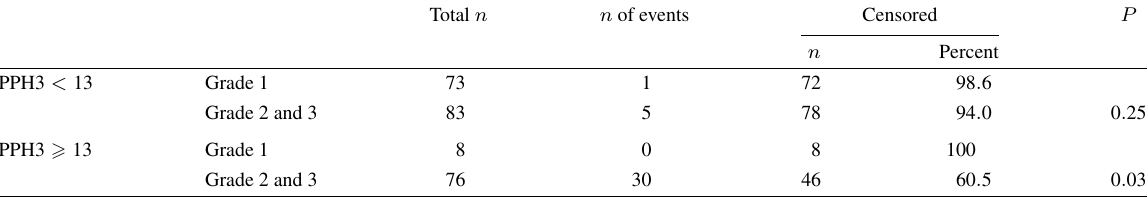
Grade 1 versus Grade 2 and 3 stratified for PPH3 < 13 and (cid:2) 13. Grade 1 versus Grade 2 and 3 have additional prognostic value to PPH3